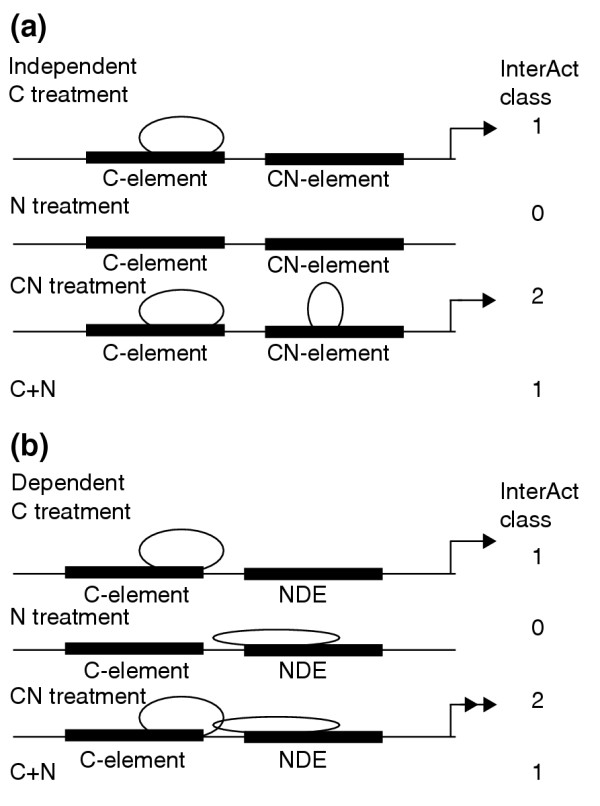
Two general mechanisms that would result in CN expression being greater than C+N. (a) Carbon (C) and CN regulatory elements are independent and do not interact. The data do not allow us to rule out the possibility that the C-element is inactive in the presence of CN and that the CN-element alone results in more expression than the C-element. (b) CN and carbon regulation are dependent. The increase in expression due to CN requires two interacting cis elements, one of which is a C-element and the other a nitrogen-dependent enhancer of carbon regulation (NDE).